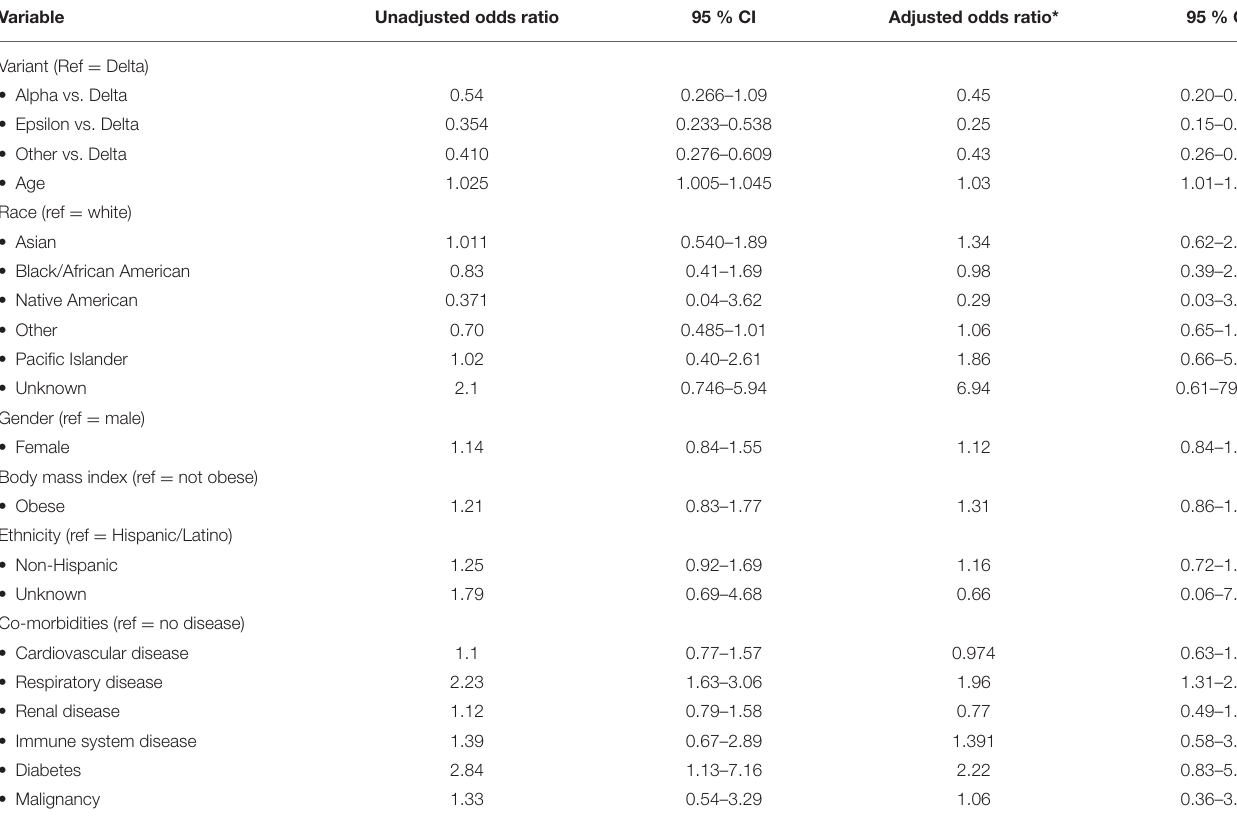
TABLE 3 | Unadjusted and adjusted odds ratios and confidence intervals for disease severity.